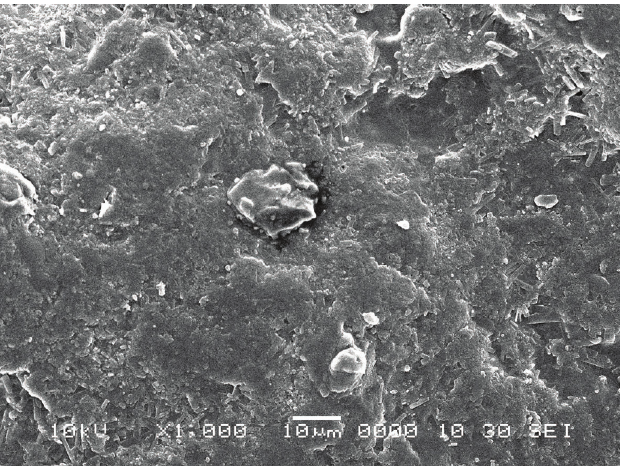
FIGURE 10 - Scanning electron microscopy of sustained release pellets after compression